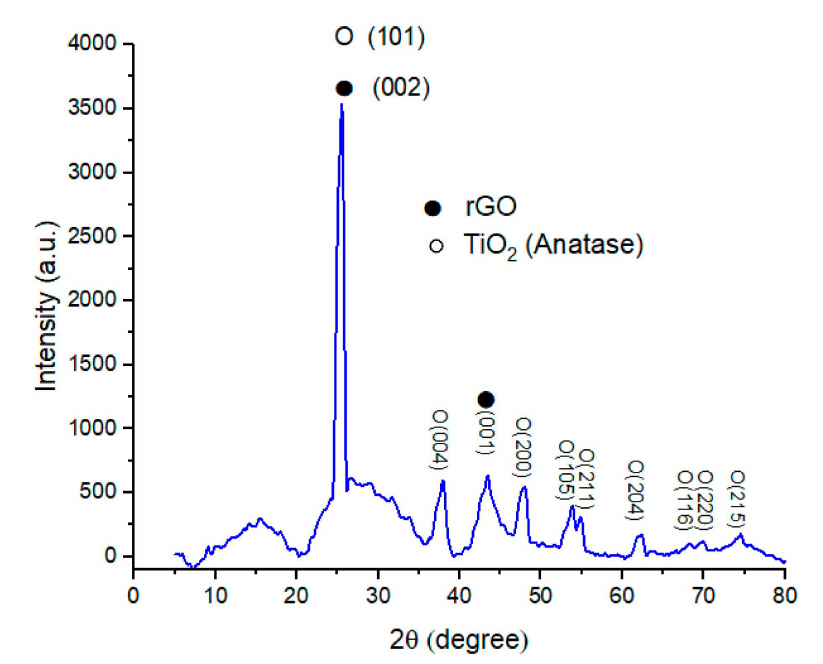
Figure 9. XRD pattern for the 3D black TiO 2 /Ag/N@rGO solar absorber. The optical performance and corresponding band gap of the black TiO 2 were deter- mined and compared with the pristine TiO 2 . As displayed in Figure 10a, the black TiO 2 demonstrated broadband solar absorption across the UV-Vis NIR region monitored, demon- strating its strong potential for the synergistic enhancement of the overall photothermal performance of the 3D black TiO 2 /Ag/N@rGO solar